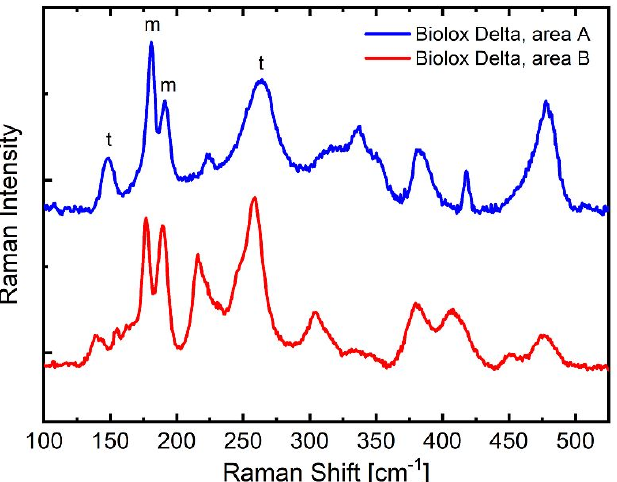
Figure 5. Comparison of Raman spectra of Delta that underwent a low monoclinic transformation (blue line—area A) and a high monoclinic transformation (red line—area B). Peaks belonging to the monoclinic (m) and tetragonal (t) phases of the area used in the analysis are labeled on the upper (area A) spectrum. The area A spectrum is associated with V m = 10% and 31% with the Clarke/Adar and Katagiri equations, respectively. In area B, the monoclinic content amounts to 67% and 90% (according to the Clarke/Adar and Katagiri equations, respectively). Such a high monoclinic content as obtained from the Katagiri equation seems unlikely given the still very strong intensity of the tetragonal peak at ~265 cm − 1 .